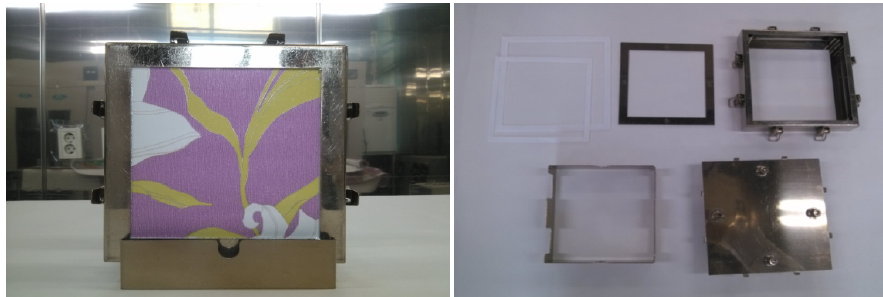
Figure 1. Photograph of an example wallpaper test sample. Parts of specimen holder Installed